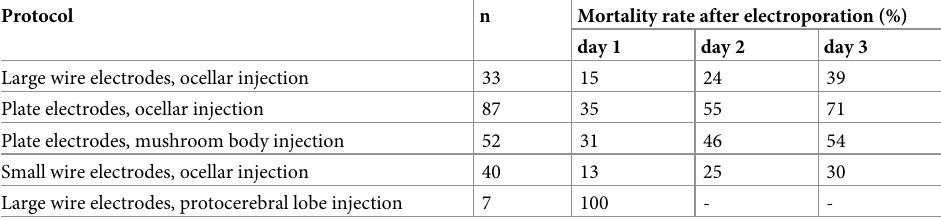
Table 2. Mortality rates after electroporation using different